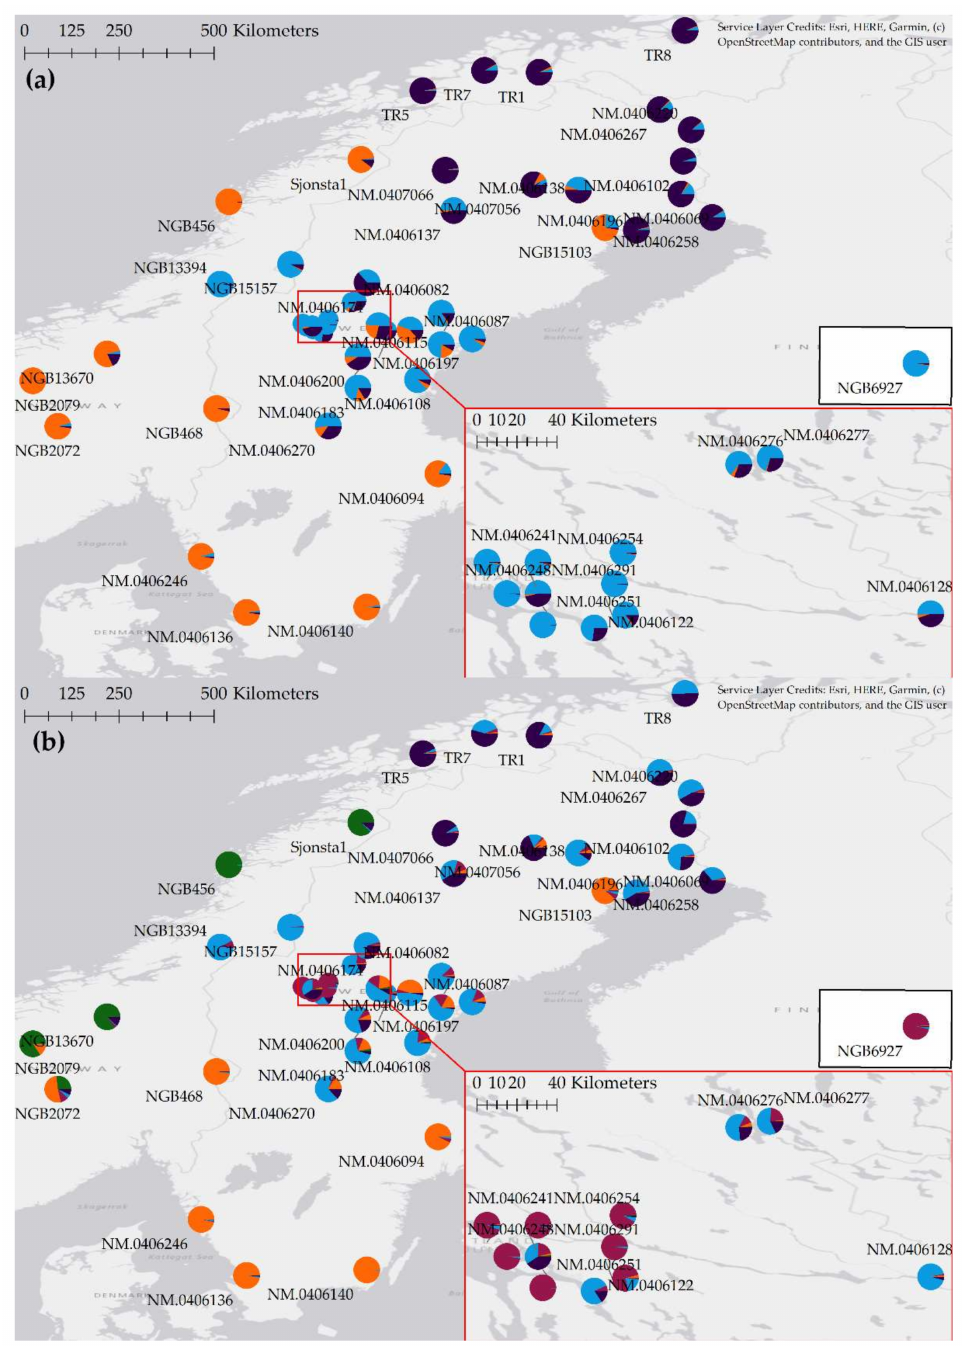
Figure 4. Geographic structuring among accessions plotted on map assuming ( a ) three clusters, ( b ) five